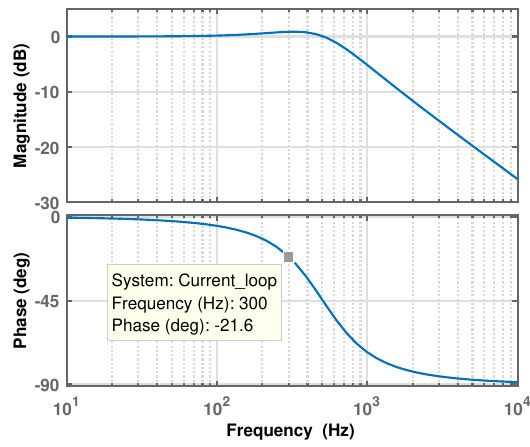
Figure 11. Bode diagram of closed current loop with PI